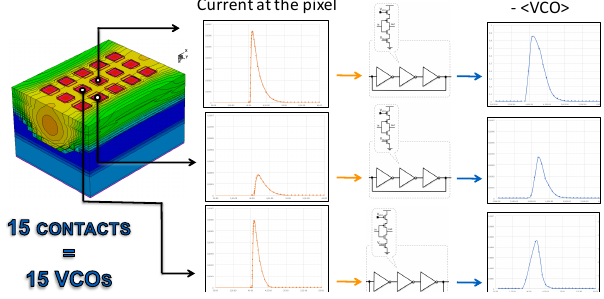
Fig. 4. Schematic presenting the process of simulation for three pixels.